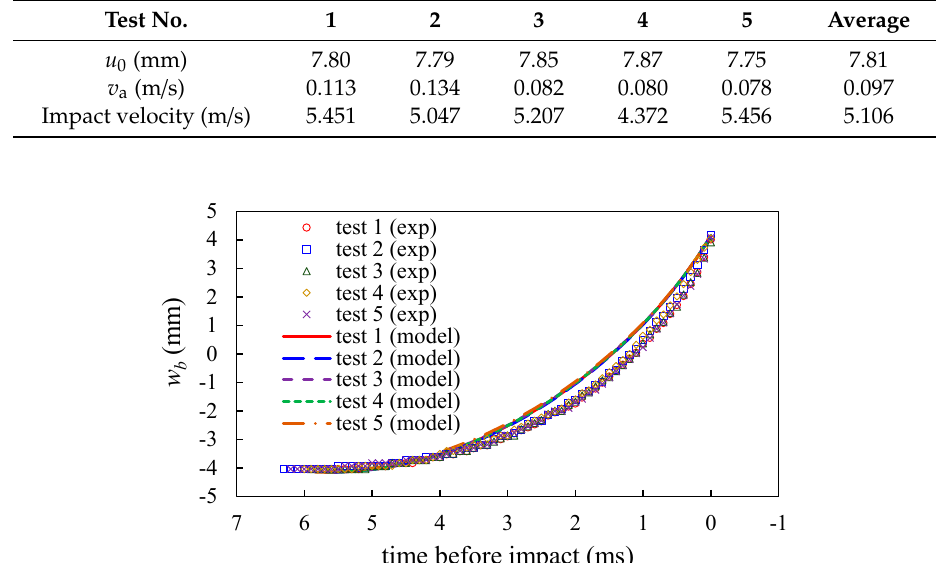
Table 3. Measurement results of u 0 , v a , and impact velocity before impact for the five tests.